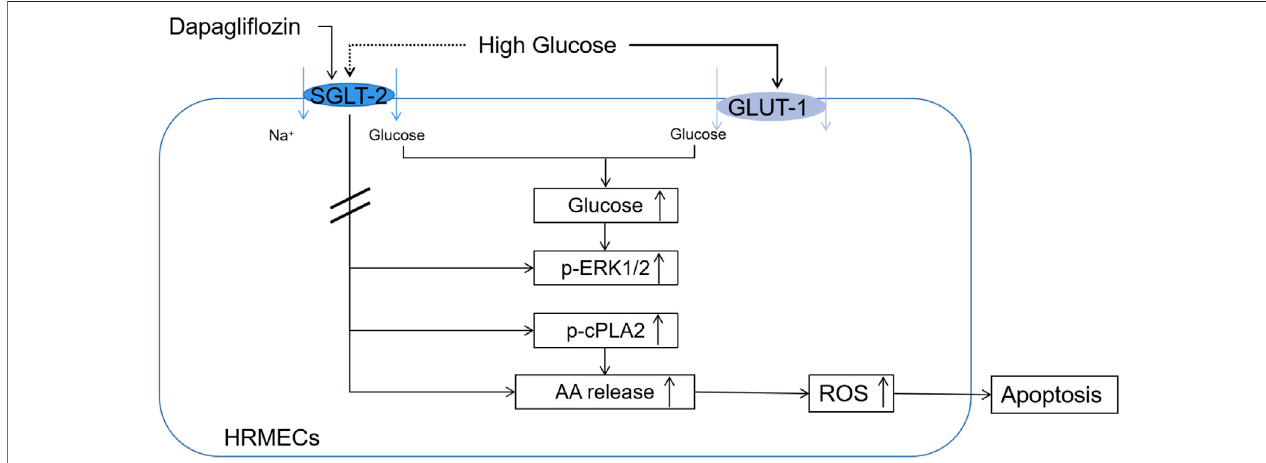
FIGURE 7 | Mechanism of DAPA acting on